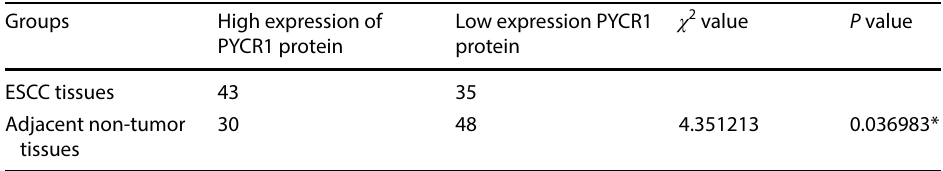
Table 5 Expression and comparison of PYCR1 protein in ESCC and adjacent non- tumor tissues in tissue